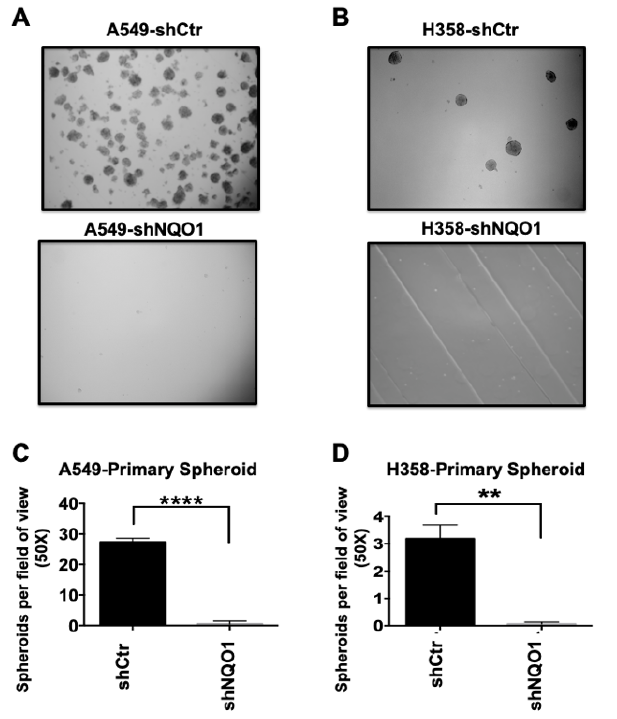
Figure 3. NQO1 depletion reduces primary tumor spheroid formation. ( A , B ) are representative images of primary spheroid formation in both A549 and H358 cell lines, respectively. A549-shCtr cells ( A , top panel ) robustly form primary spheroids in comparison to the A549-shNQO1 cell lines ( A , bottom panel ). In the H358 cell lines, again the H358-shCtr cell line ( B , upper panel ) shows an increase in the number of primary spheroids formed in comparison to H358-shCtr ( B , lower panel ). Primary spheroid counts are quantified for A549 and H358 in ( C ) and ( D ), respectively (**** p < 0.0001; ** p = 0.0035).